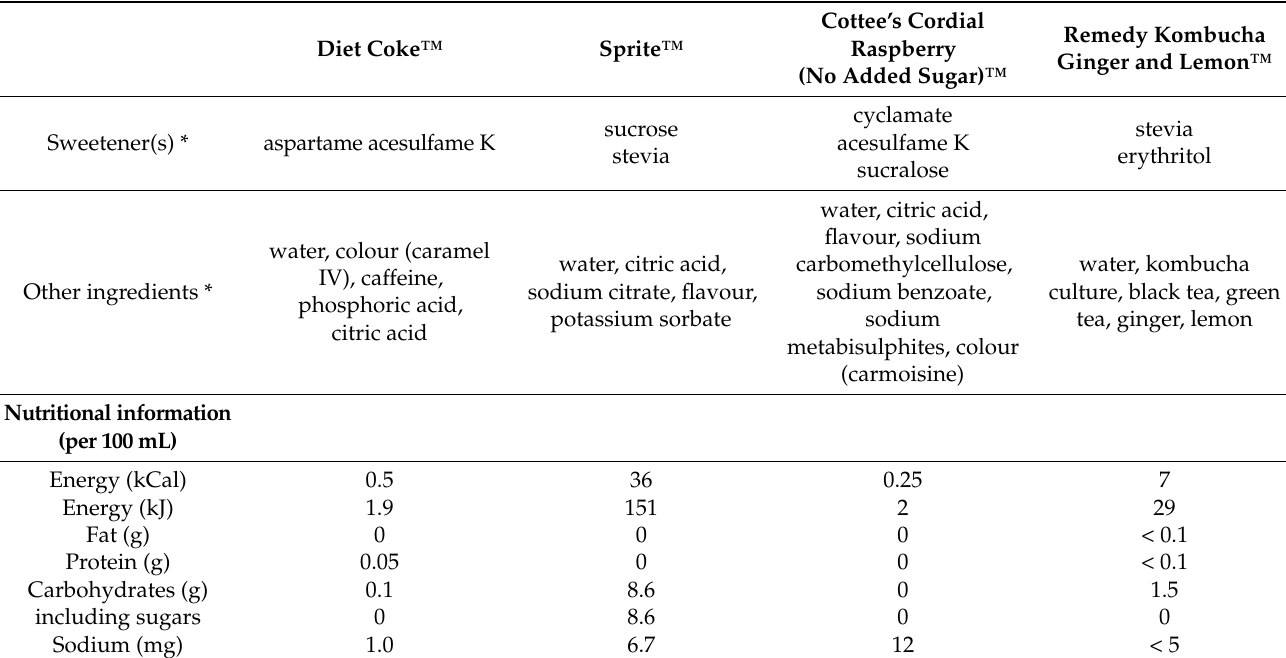
Table 1. Components and nutritional information of the commercially available drinks administered during preference and acceptance testing and the four-week period following chronic sucrose